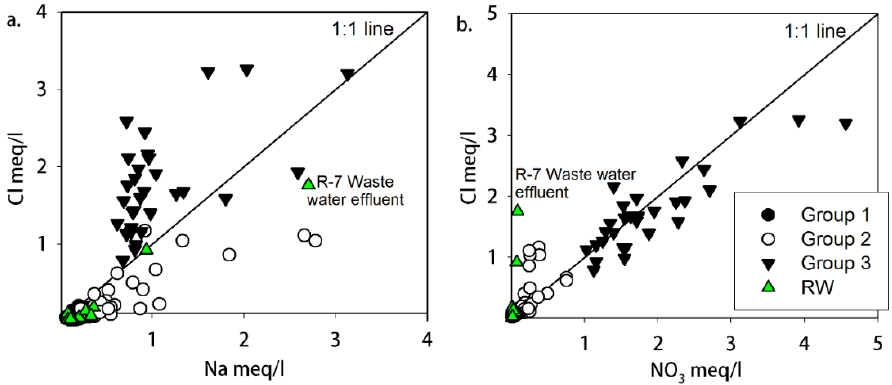
Figure 9. Relationships of ( a ) Na vs. Cl and ( b ) NO 3 vs. Cl in various water resources.